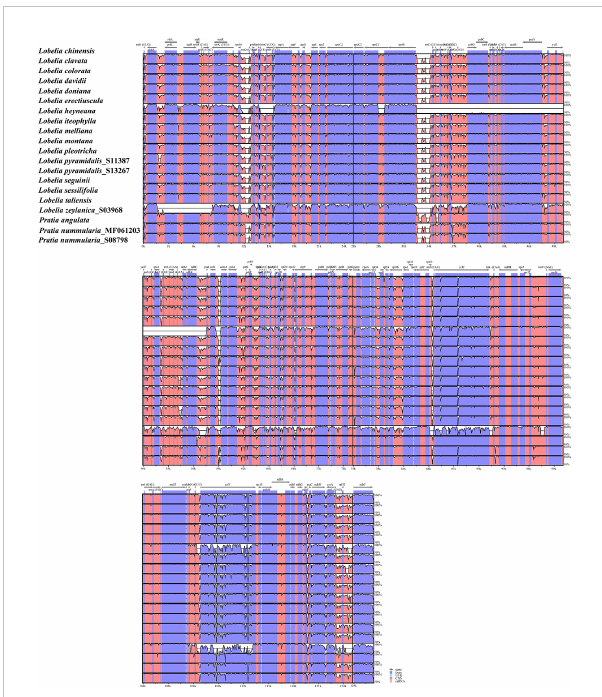
FIGURE 3 Visualization of the alignments of twenty plastomes representing all sections of East Asian lobelias using mVISTA, with Lobelia chinensis as the reference sequence. The gray arrows above the alignment indicate genes. Different colors represent different regions (coding and non-coding). The horizontal axis indicates the coordinates within the plastid genome. The vertical scale represents the percentage of identity, ranging from 50% to